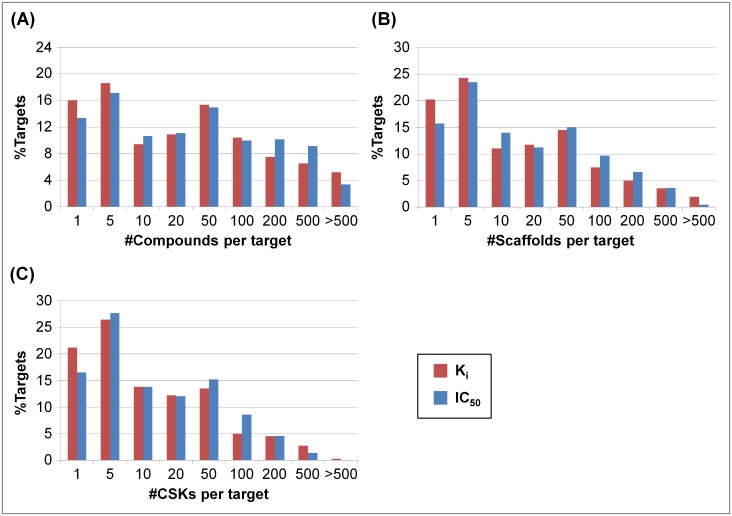
Distributions of compounds, scaffolds, and cyclic skeletons.The percentage of targets with increasing numbers of (A) compounds, (B) scaffolds, and (C) CSKs is reported for the Ki (red) and IC50 (blue) data sets.